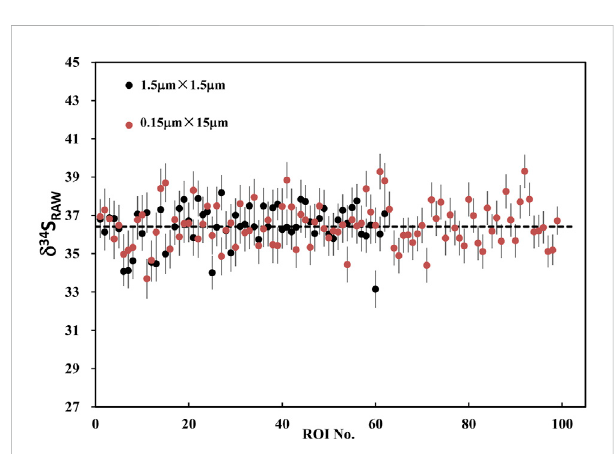
FIGURE 10 The plot of RAW δ 34 S on PY-1117 with the rectangular ROIs